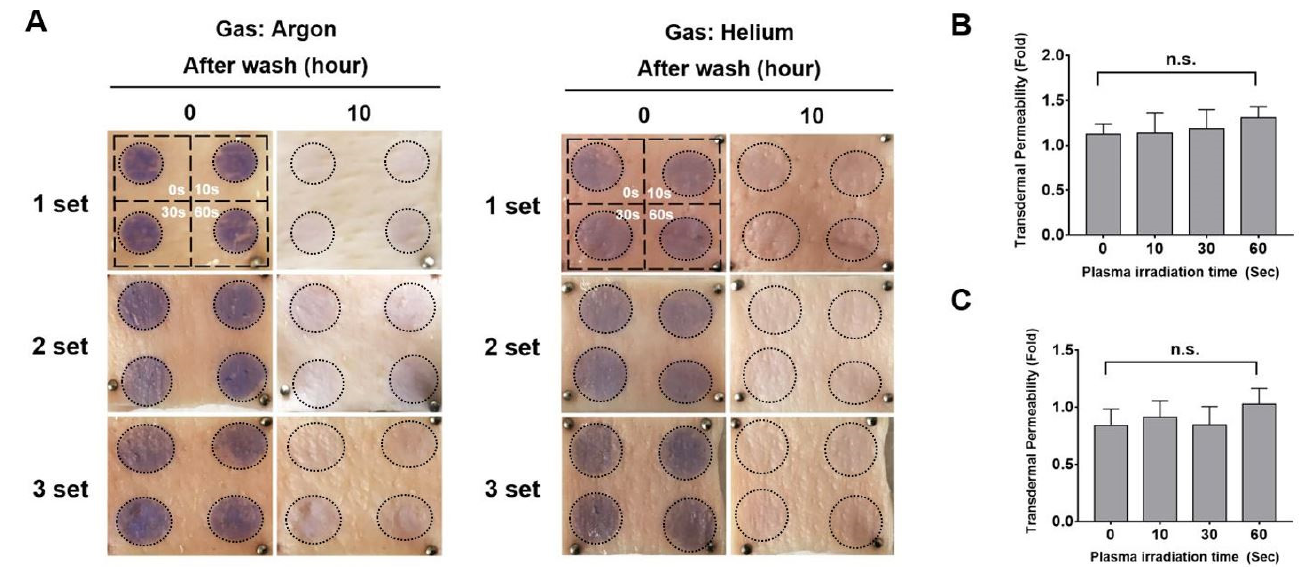
Figure 5. Transdermal absorption of aniline blue dye on porcine skin by argon and helium plasma irradiation at a distance of 8 mm ( A ) The quartered area of the rectangular area in porcine skin was treated with argon or helium plasma for 0, 10, 30, or 60 s at a distance of 8 mm between the plasma jet and the surface of the skin and thereafter stained with aniline blue dye. The transdermal permeability of aniline blue dye on porcine skin was quantified and normalized to that of the nontreated control. ( B , C ) Data are presented as means ± S.D. n.s indicates a nonsignificant difference compared to the nontreated control (one-way ANOVA, Tukey’s post hoc test) with argon ( B ) or helium ( C ). n = 3 independent samples per group.